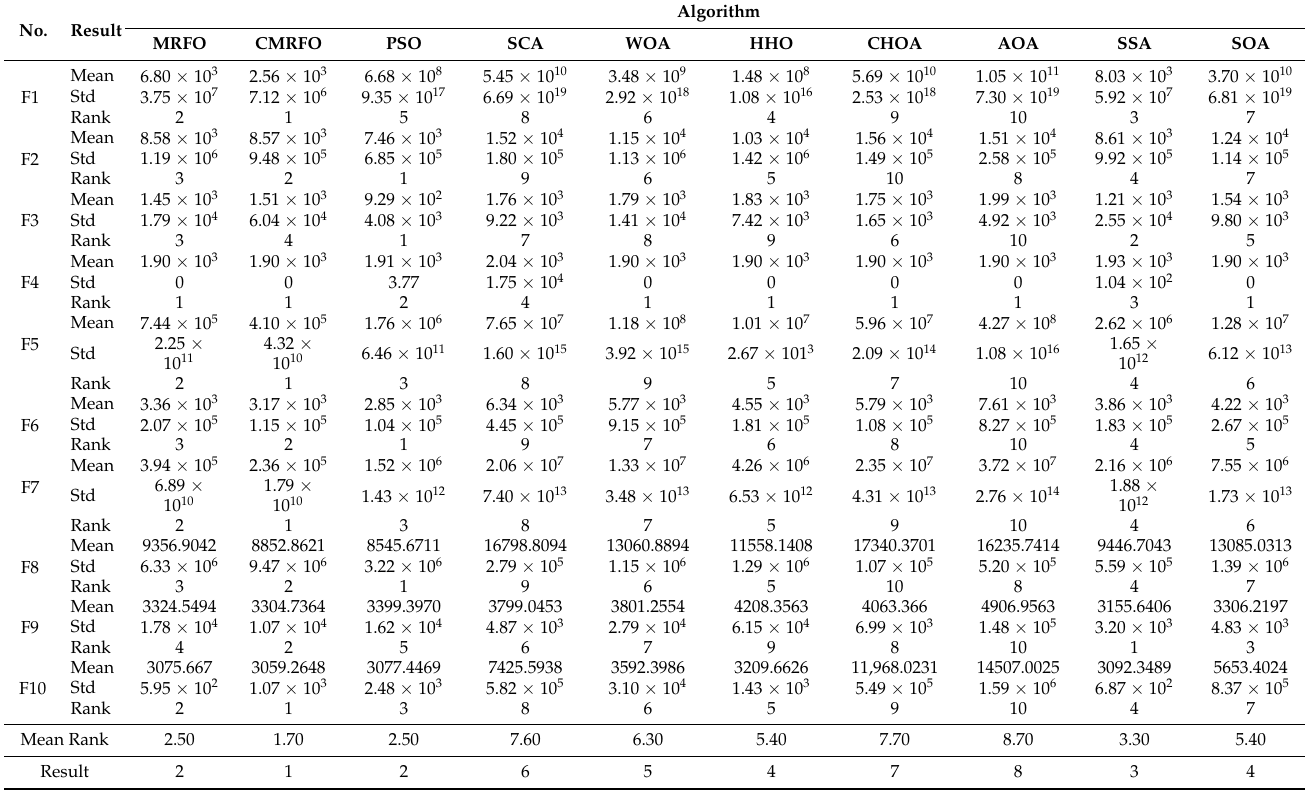
Figure 6. Convergence curves for 10 comparison algorithms (50-dimensional IEEE CEC2020). Table 9. Results of all 10 algorithms on the 50-dimensional CEC2020 test